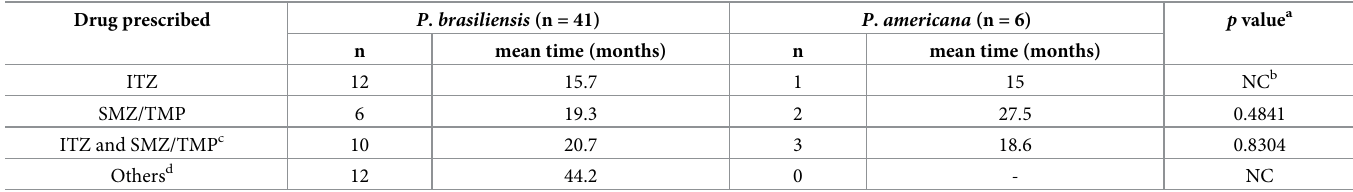
Table 3. Therapeutic aspects of patients with paracoccidioidomycosis according to the species identified in this study. Drug